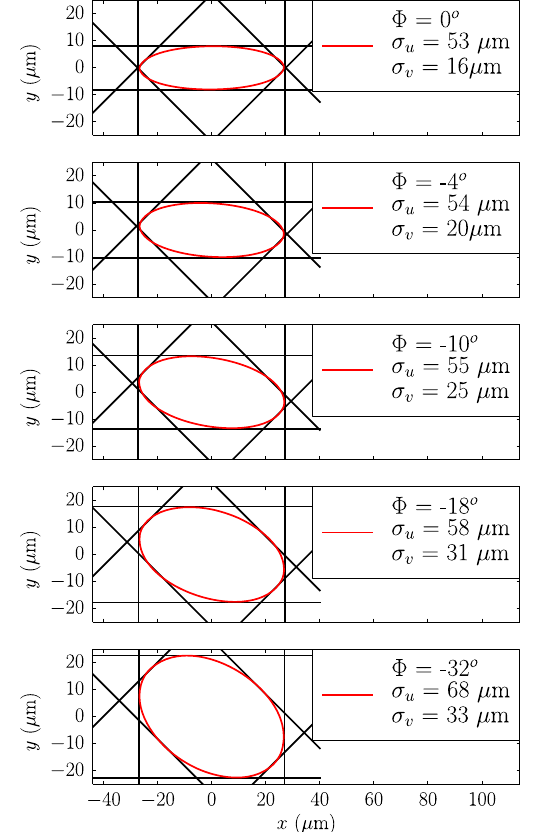
FIG. 12. Reconstruction of the beam at different couplings. Black lines are calculated from real data while the red ellipse is drawn from the result of the fit.